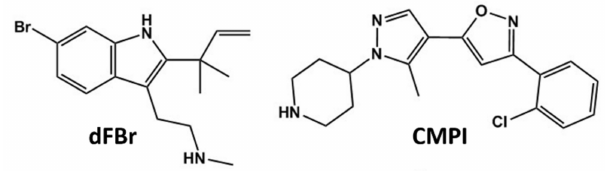
Figure 1. Structures of α 4 β 2* neuronal nicotinic acetylcholine receptors (nAChRs) positive allosteric modulators (PAMs), desformylflustrabromine (dFBr) and 3-(2-chlorophenyl)-5-(5-methyl-1-(piperidin -4-yl)-1 H -pyrazol-4-yl)isoxazole